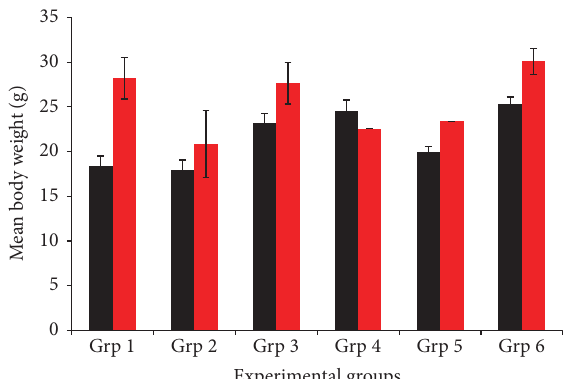
Figure 2: The mean body weight of mice infected with P. berghei and treated with aqueous leaf extracts of V. amygdalina , C. papaya, and halofantrine. Black colour indicates preinfection; red colour indicates day 9, except in Grp 5 (indicating day 6).